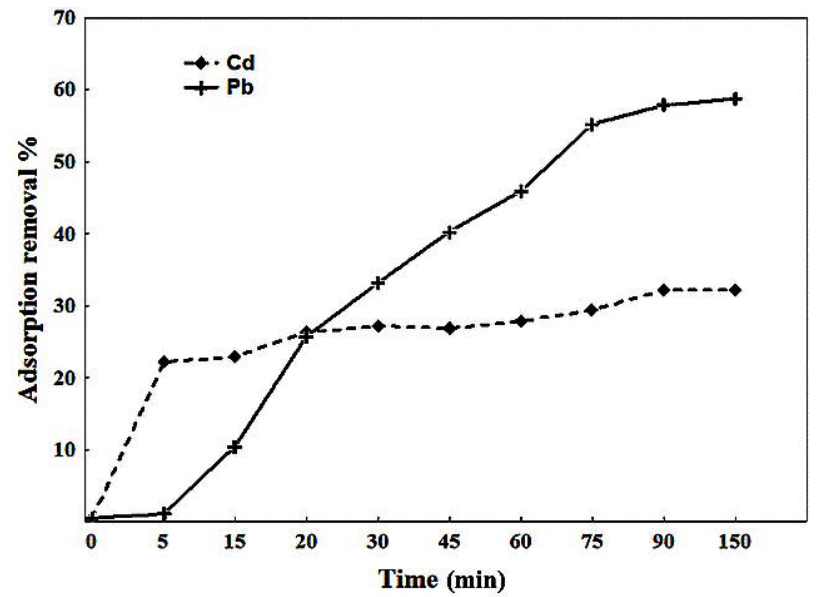
Figure 9. Cd and Pb adsorption onto FeNP/NFC composite as a function of